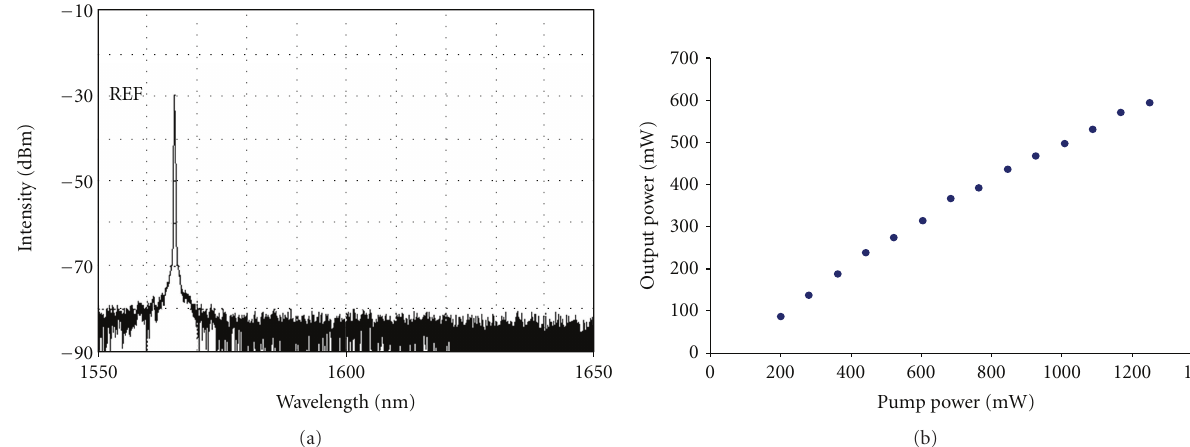
Figure 4: (a) Output of the laser obtained with OSA; (b) input-output characteristics of the laser without the SA for λ = 1565 . 52nm.